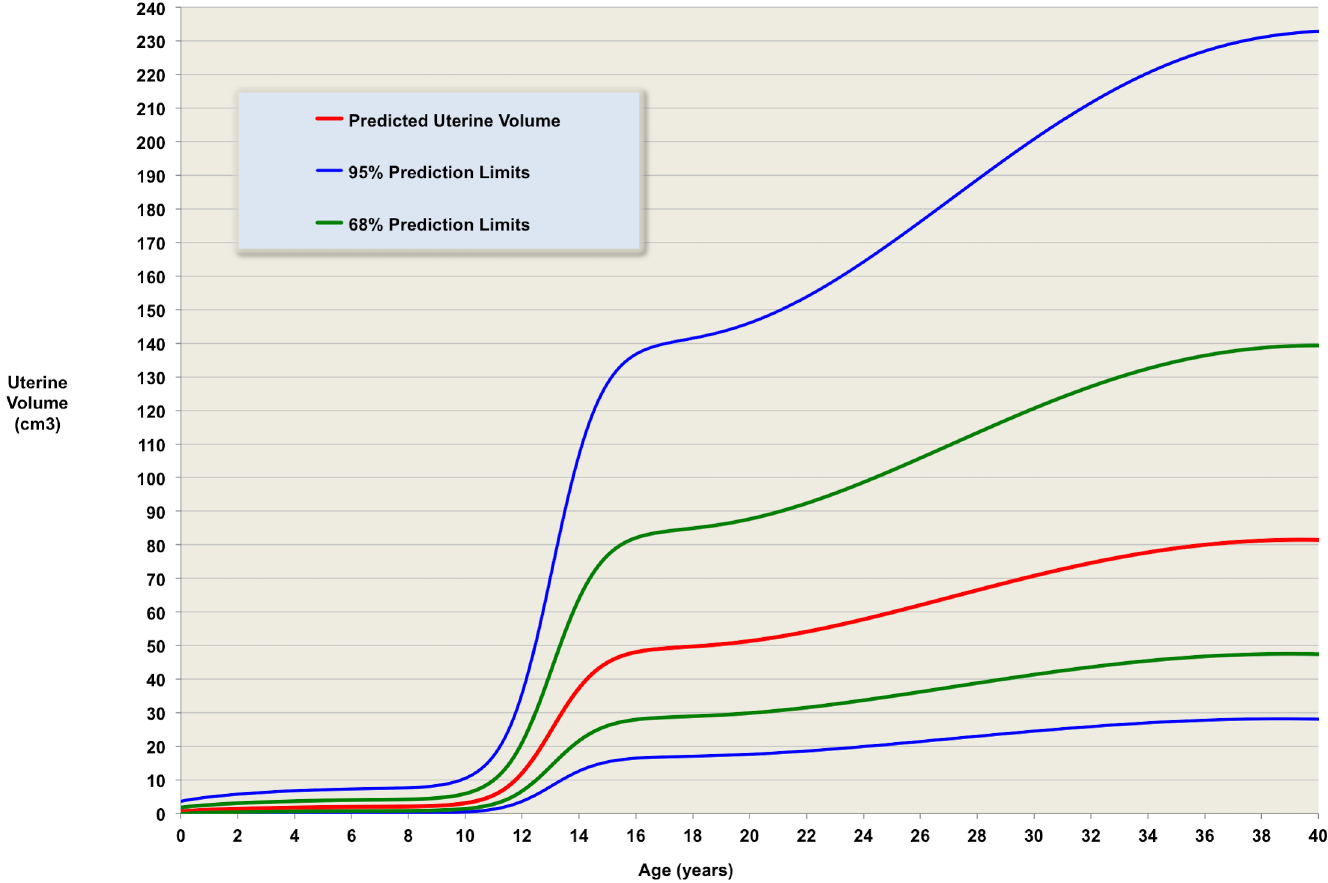
Fig 4. The validated model. Predicted uterine volume for ages from birth to 40 years, with one and two standard deviations prediction limits – 68% of measurements at a given age are expected to be between the green lines; 95% are expected to be between the blue